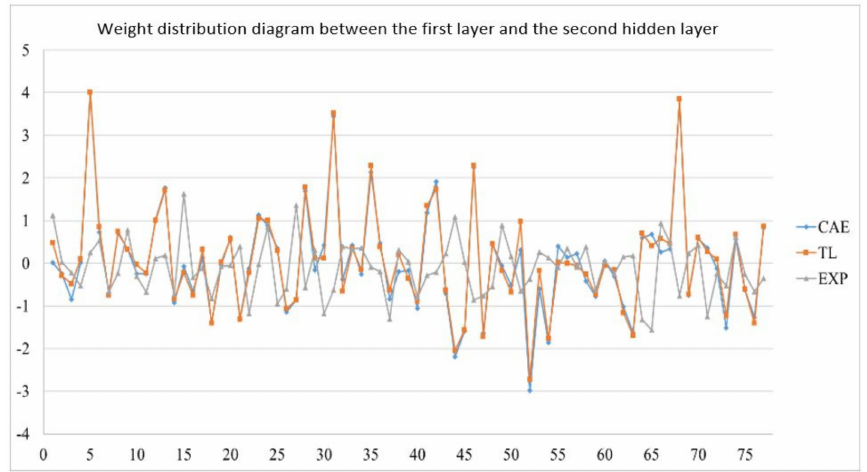
Figure 22. Weight distribution diagram between the first layer and the second hidden layer.